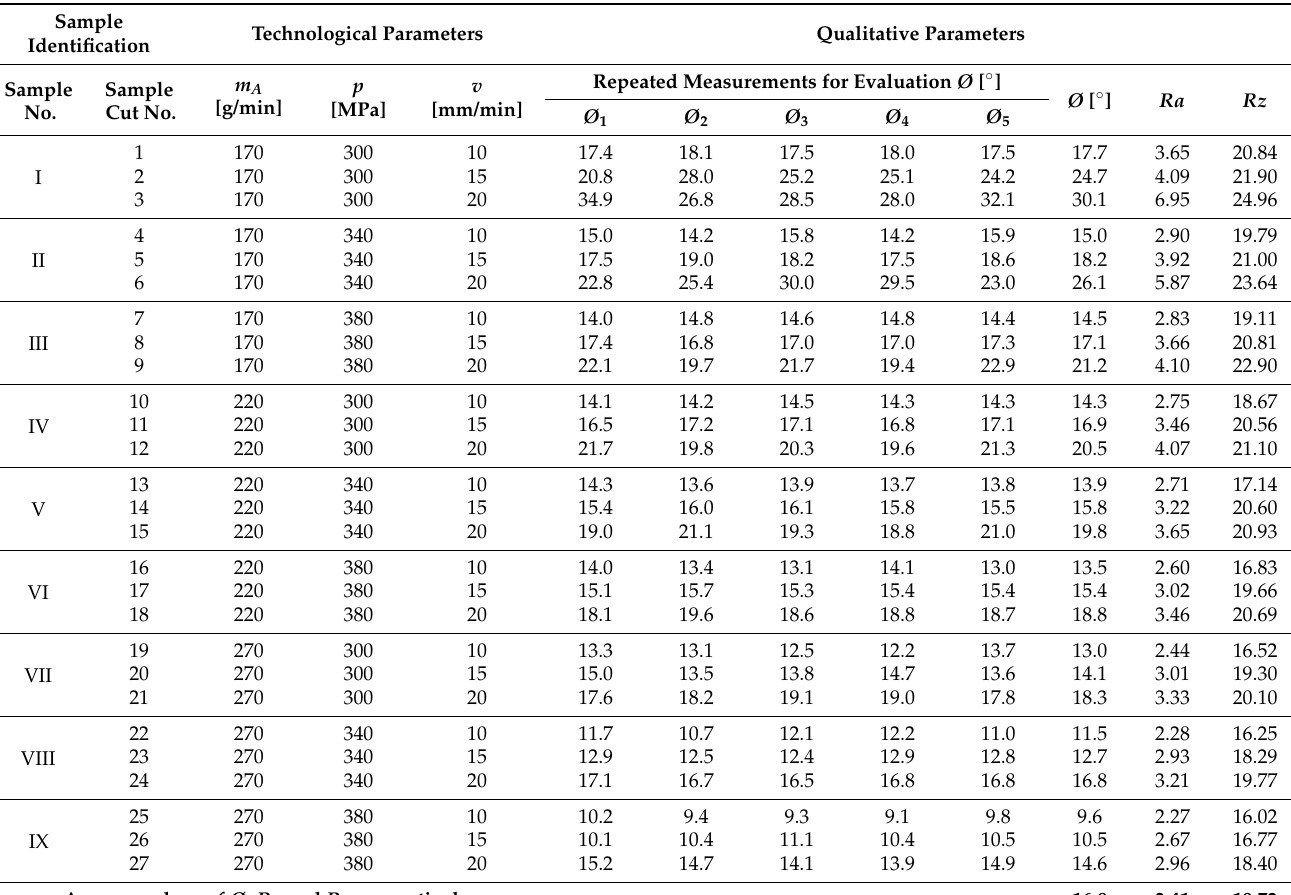
Table 1. Values of the deflection of the abrasive water jet track Ø and the roughness parameters Ra and Rz as measured on the cut surfaces of the samples.